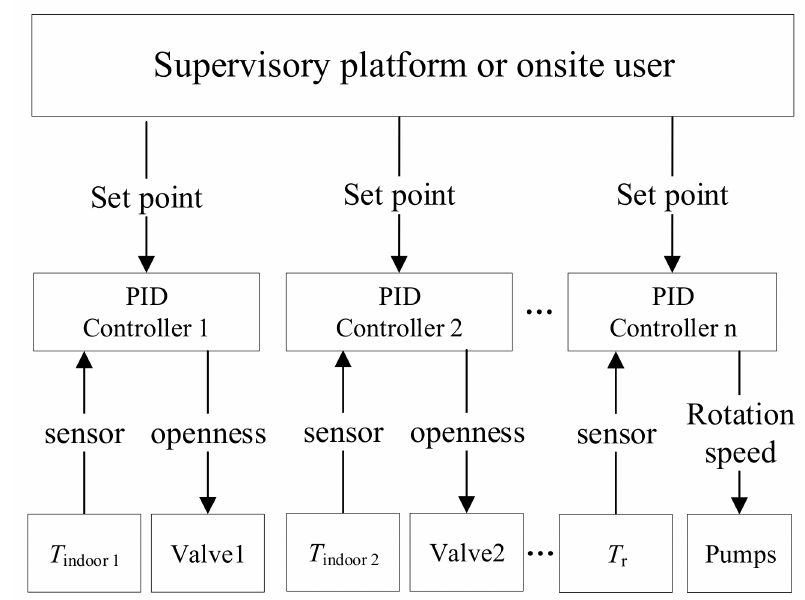
Figure 2. A schematic control diagram of a typical PID control method.